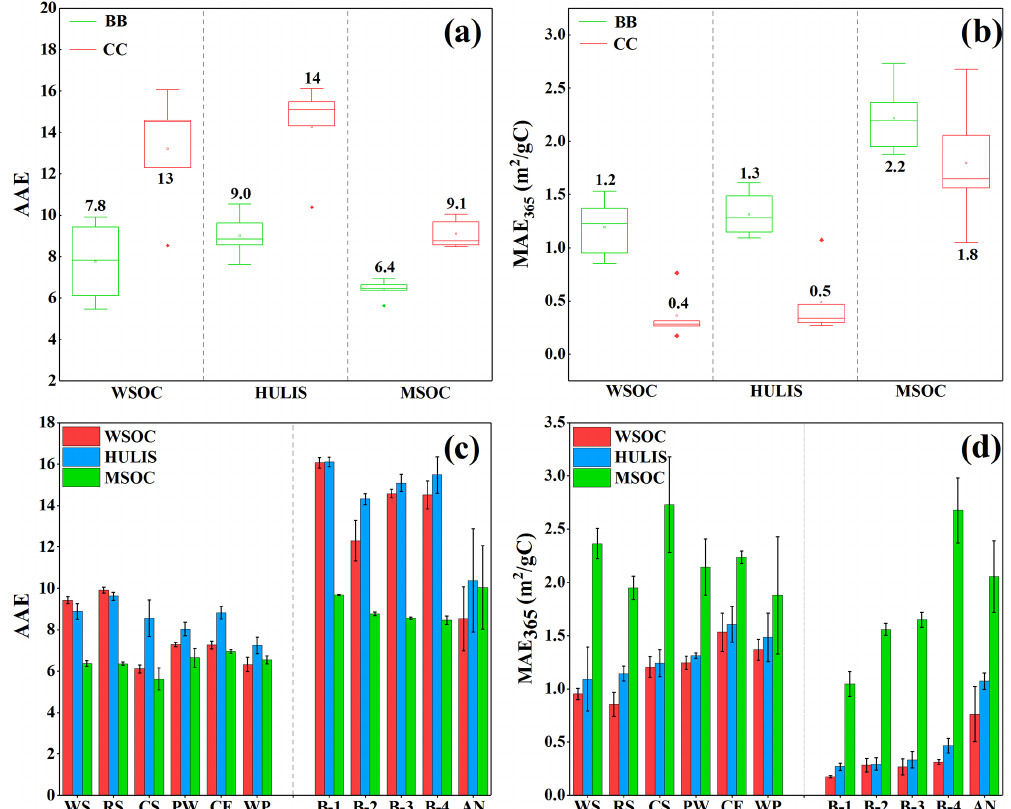
Figure 2. The AAE and MAE 365 values of WSOC, HULIS, and MSOC in smoke samples from biomass burning (BB) and coal combustion